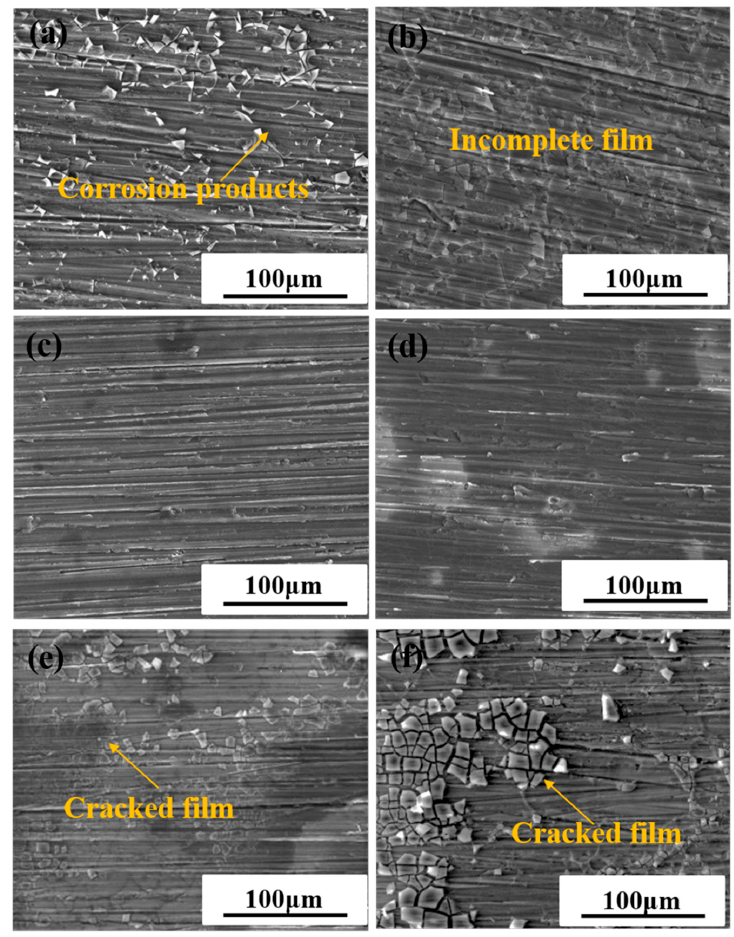
Figure 10. SEM images of corrosion morphology of 5083 aluminum alloy beneath coatings with different content of PANI-SSA ( a ) 0.1 wt. %; ( b ) 1 wt. %; ( c ) 2 wt. %; ( d ) 4 wt. %; ( e ) 6 wt. %; ( f ) 8 wt. % after immersion.